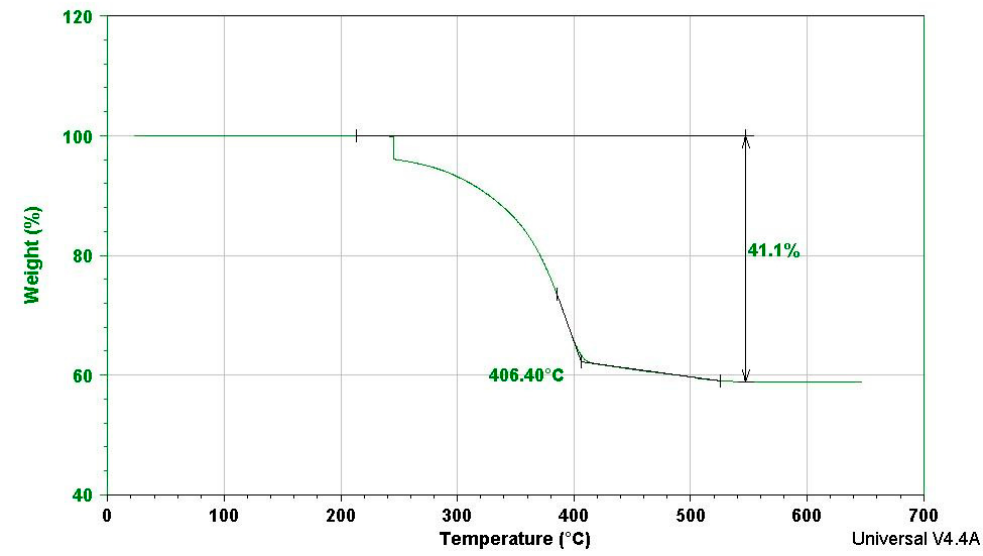
Figure 5. TGA curve of as-received PP-GF recyclate. The actual data begins at 98 wt% since there was some loss of data in the 100–98 wt% region.